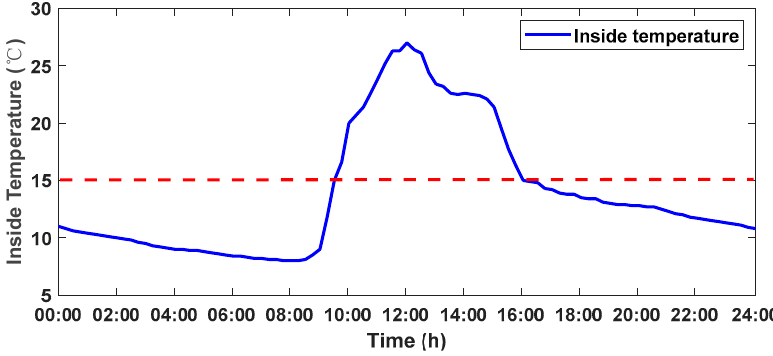
Figure 10. The inside temperature of the CSG on 26 January 2018.